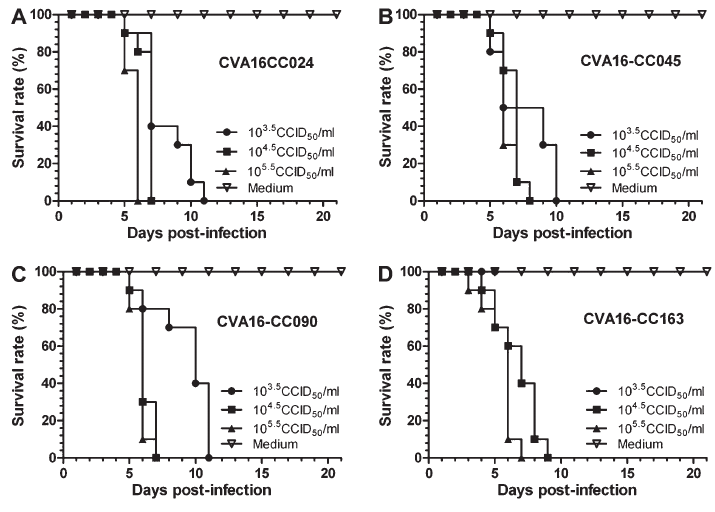
Figure 3. Survival of neonatal mice infected with circulating Coxsackievirus A16 (CVA16) Changchun (CC) strains CC024, CC045, CC090 or CC163 at different doses. Neonatal mice in each group (n=8-10 per litter) were intracerebrally infected with each of the above CVA16 strains at different doses from 10 3.5 to 10 5.5 CCID 50 /mL, or mock infected with DMEM